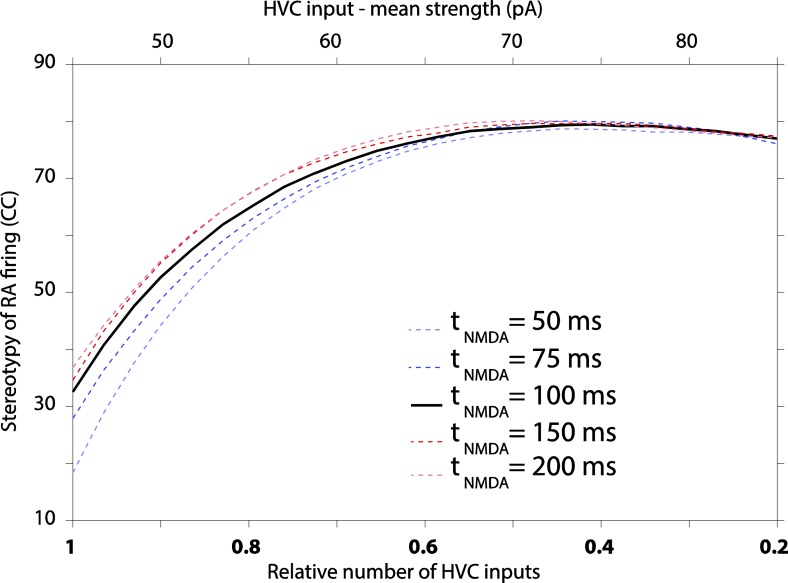
The effect of varying decay kinetics of NMDA currents in our model results in modest changes to RA variability, with longer time constants producing more stereotyped firing.